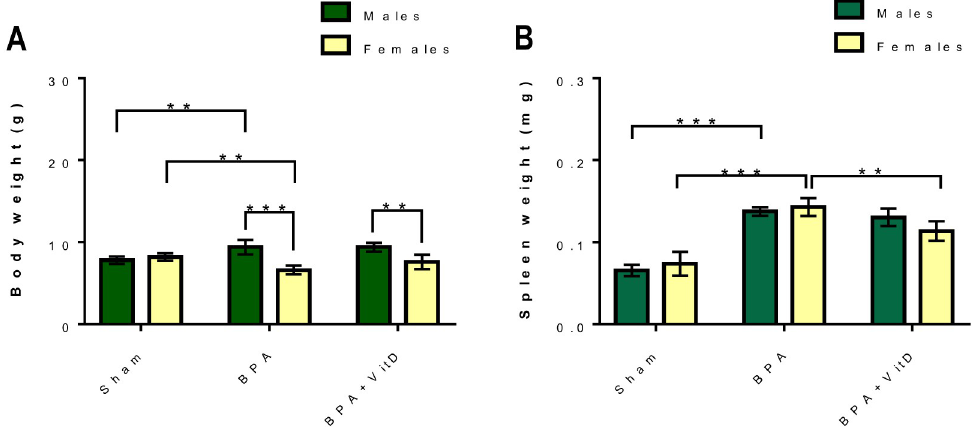
Fig 3. Effect of VitD and BPA on mice body and spleen weight. (A) Quantification of body weight, (B) Quantification of spleen weight. Data are represented as mean ± SD (n = 12), and P < 0.01 is represented as �� , while P < 0.001 is represented as ���